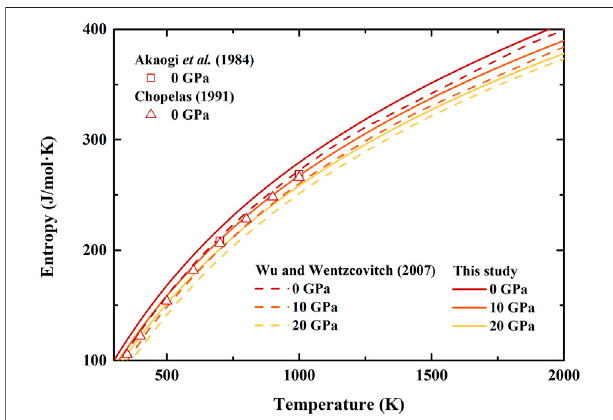
FIGURE 5 | Temperature dependence of entropy of β - (Mg 0.87 Fe 0.13 ) 2 SiO 4 and β -Mg 2 SiO 4 at various pressures. Solid lines: result of β -(Mg fi rst principle calculation 0.87 Fe 0.13 ) 2 SiO 4 from this study; Dash lines: result of β -Mg 2 SiO 4 by Wu and Wentzcovitch (2007); Squares and Triangles:results of β -Mg 2 SiO 4 obtainedfrom differential scanningcalorimetry measurement by Akaogi et al. (1984) and Chopelas (1991), respectively.